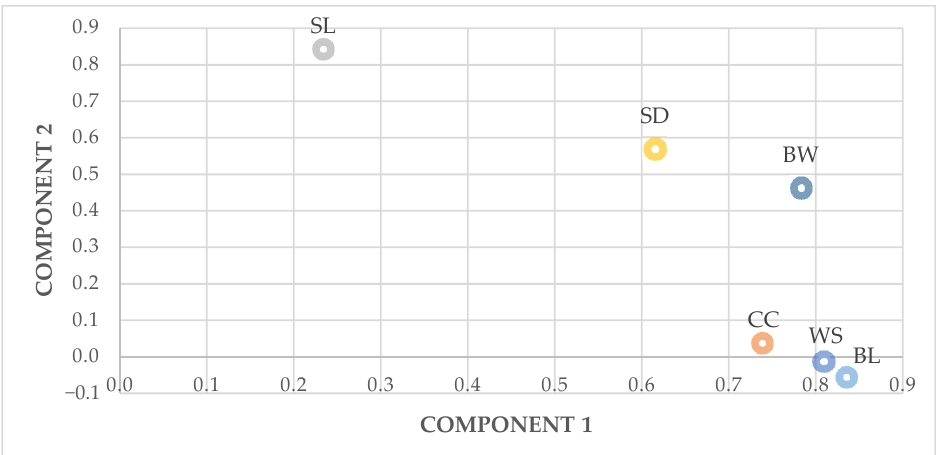
Figure 2. Principal Component Analysis of the zoometric measures in roosters. BW: body weight; BL: body length; CC: chest circumference; SL: shank length; SD: shank diameter; WS: wingspan. In females, the two principal components extracted accounted for 62.8% of the total variance in the original variables with eigen values of 2.809 and 0.809 for PC1 and PC2, respectively. PC1 was most highly correlated with body weight (0.855), chest circumference (0.817) and body length (0.631) and PC2 had high positive loadings on shank length (0.834) and wingspan (0.692) (Figure 3).